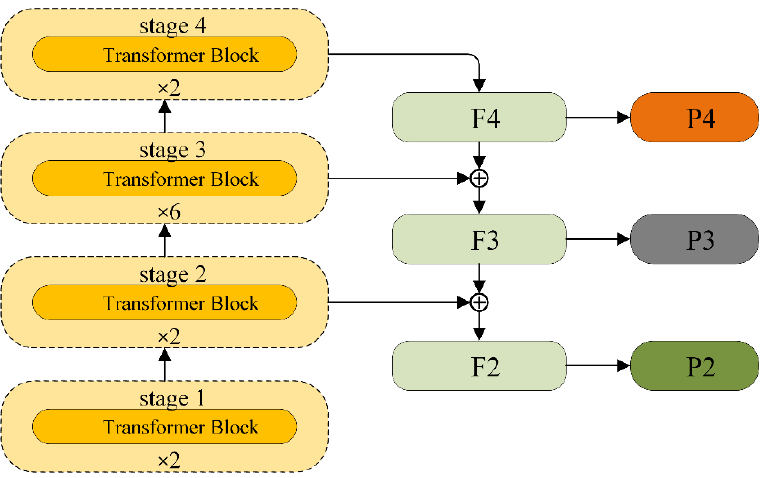
Figure 2. Backbone structure and multilevel feature fusion.